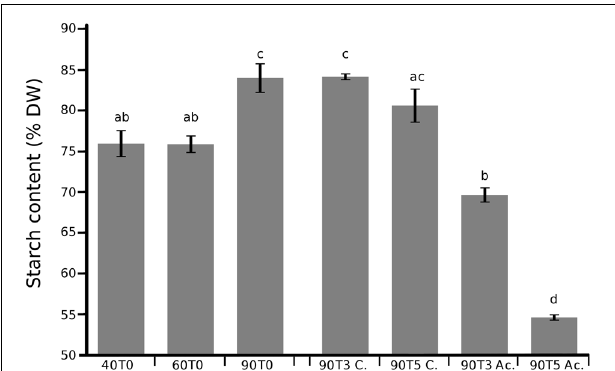
FIGURE 8 | Accumulation and decrease of starch in banana fruits. Starch content is expressed in % of dry weight (DW) and was measured individually on fruits harvested at 40, 60, and 90 DAF (40T0, 60T0 and 90T0, respectively) and on fruits harvested at 90 DAF then treated 24 h with acetylene and stored two or four additional days (90T3 Ac. and 90T5 Ac., respectively) and on control fruits not treated and stored three (90T3C.) and 5 days (90T5C.). Three biological replicates were analyzed for each condition. Means, standard errors and different groups from multiple comparisons with confidence interval at 95% (ANOVA followed by Tukey’s test) are